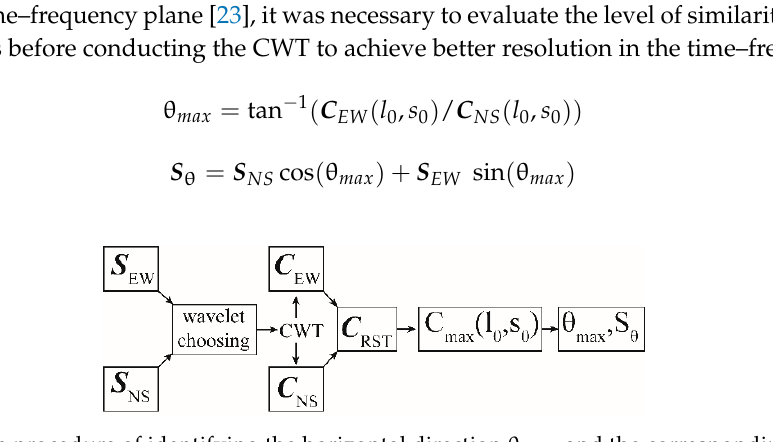
Figure 4. The typical single and multiple pulse waveforms: ( a ) TCU075, ( b ) NSY, ( c ) TCU060, and ( d ) TCU128. Representation of the dominant multi-pulse waveform embedded in the signal 𝑺 (cid:3087) was carried out by applying the CWT to the residual signal 𝑺 𝜽,𝒊(cid:2880)𝟎 = 𝑺 𝜽 in an iterative manner. The purpose of CWT was to extract dominant pulses, which was different from stage 1 aimed at identifying θ (cid:3040)(cid:3028)(cid:3051) . Before extracting the individual dominant pulses, the optimum mother wavelet was determined first by the adaptive mother wavelet selection procedure, considering the specific feature of the signal 𝑺 𝜽,𝒊 . The largest wavelet coefficient C (cid:3036),(cid:3040)(cid:3028)(cid:3051) (cid:3435)𝑙 (cid:2868),(cid:3036) , 𝑠 (cid:2868),(cid:3036) (cid:3439) in the time–frequency plane C (cid:3036) (𝑙, 𝑠) produced by the CWT, based on the optimum mother wavelet was used to extract the individual wavelet waveform using Equation (6), where p (cid:3036) is the i th individual pulse corresponding to C (cid:3036),(cid:3040)(cid:3028)(cid:3051) (cid:3435)𝑙 (cid:2868),(cid:3036) , 𝑠 (cid:2868),(cid:3036) (cid:3439) ,